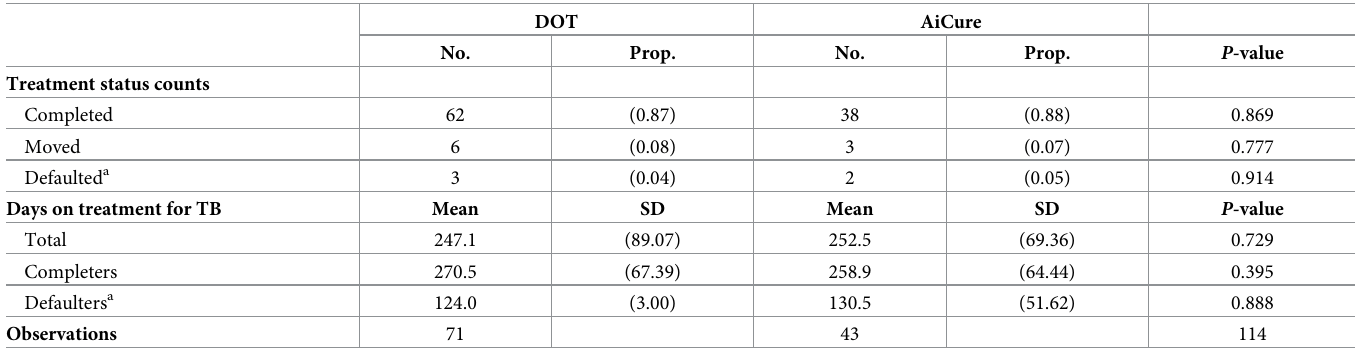
Table 3. Result statistics by treatment